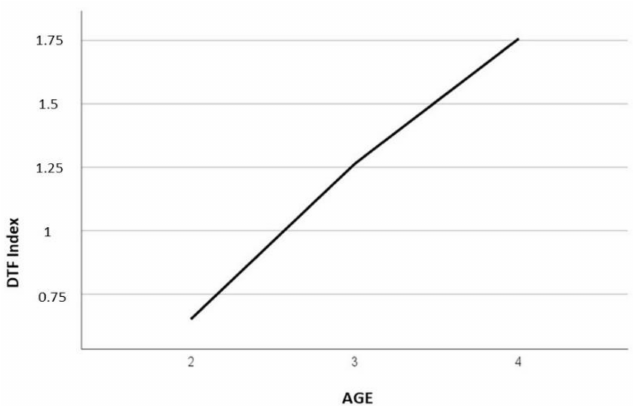
Figure 1. Decayed/filled primary teeth (dft) index and